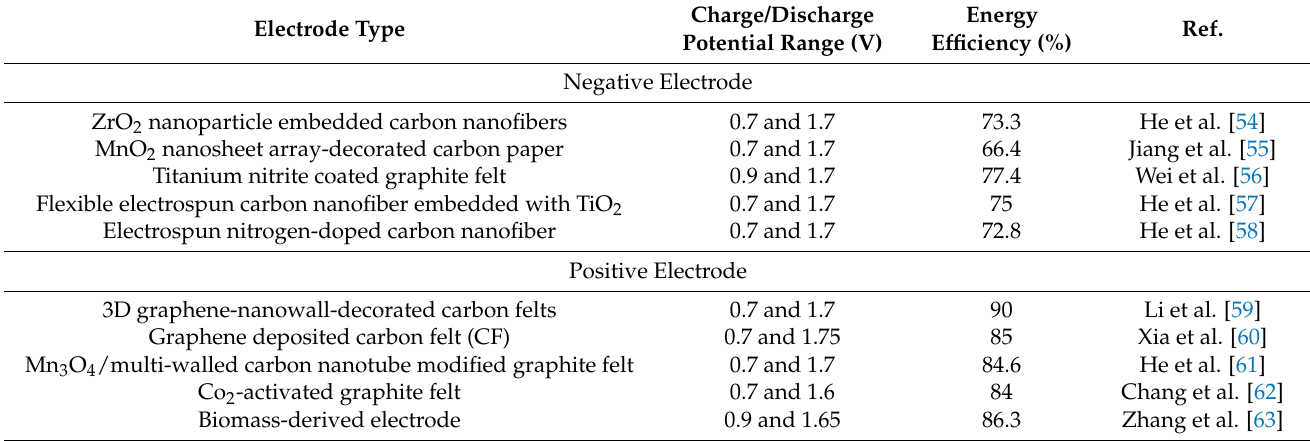
Table 3. Electrodes used as negative and positive electrode components.